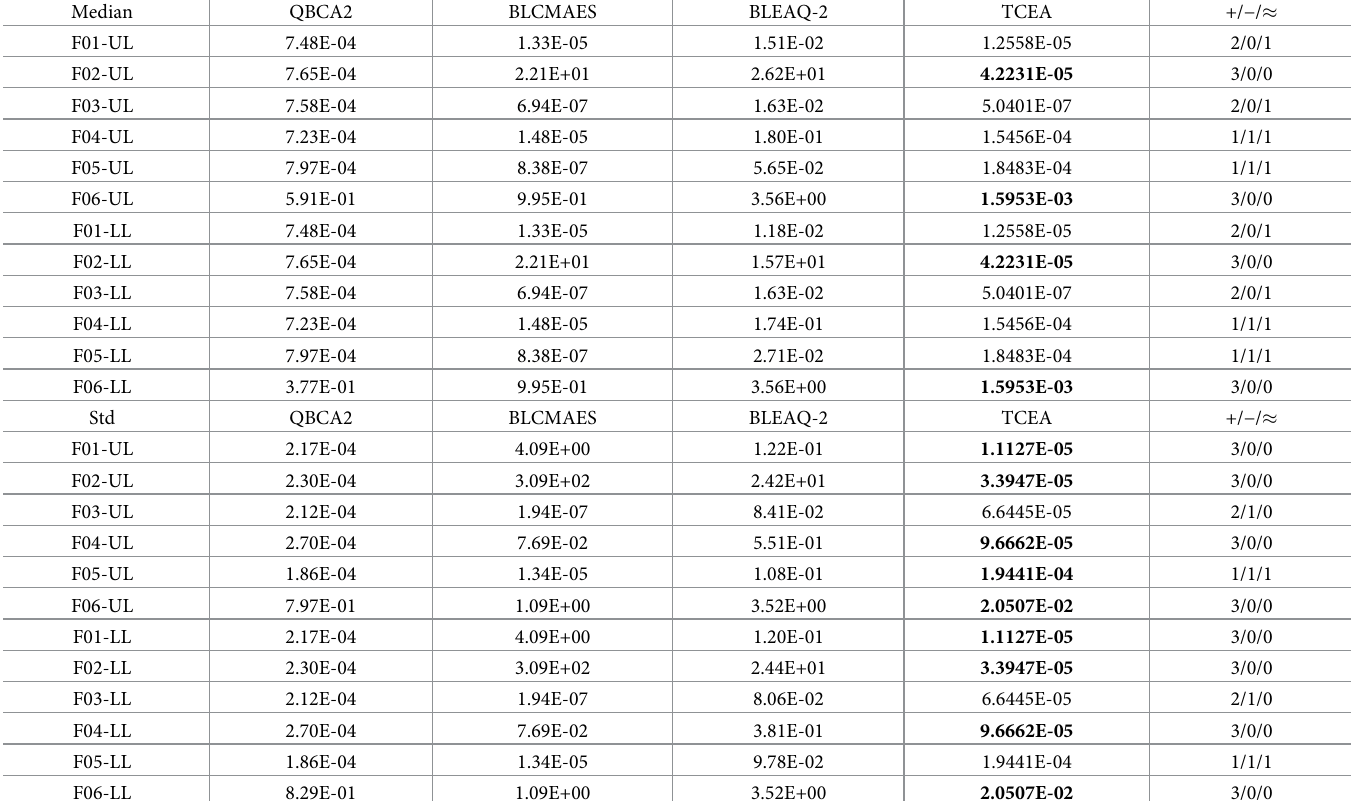
Table 6. UL and LL accuracy statistics from 31 independent runs by QBCA2, BLCMAES, BLEAQ-2 and TCEA on 10-dimensional test problems. Median